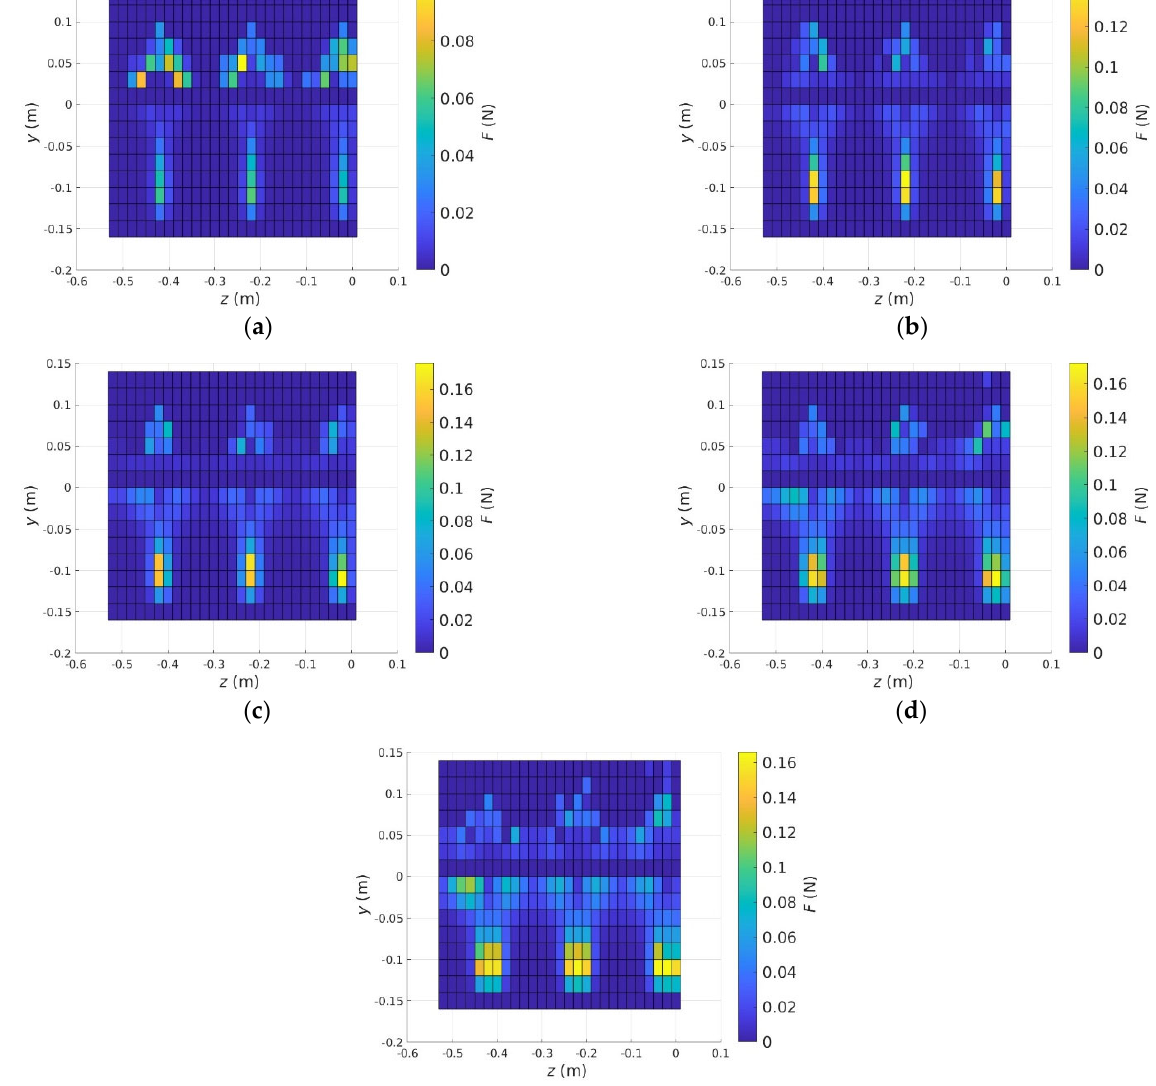
Figure 20. Contour of time-averaged forces acting on particles for various paddle width of ( a ) 0.25 A ,